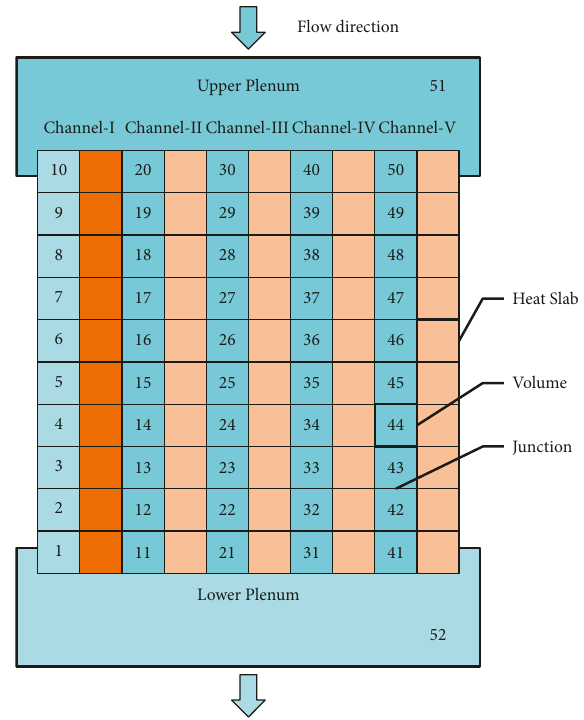
Figure 5: Schematic diagram of RSG-GAS model for EUREKA-2/RR.